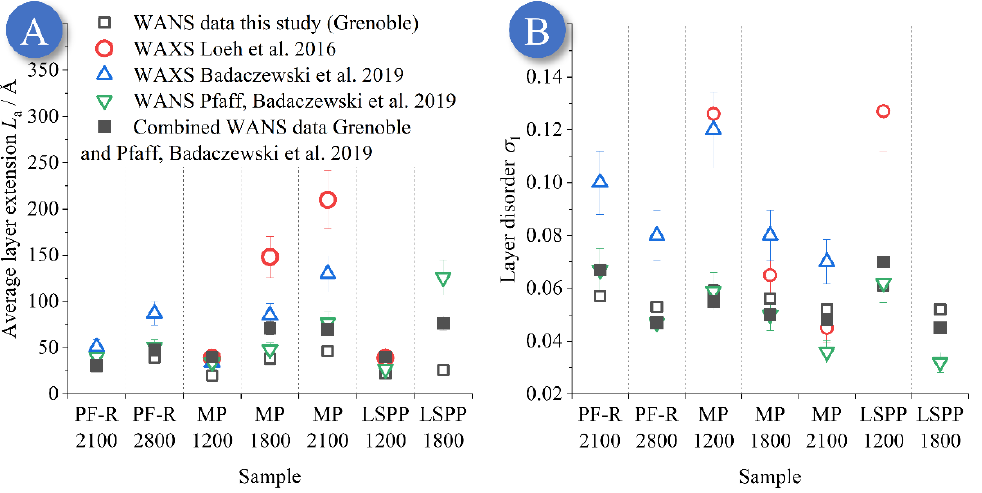
Figure 11. ( A , B ): Comparison of L a ( A ) and σ 1 ( B ) values obtained from different scattering experiments using X-ray and neutron radiation for identical samples. Black border only: WANS results from WANS data collected in Grenoble. Red: WAXS results from Loeh et al. (2016) [40]. Blue: WAXS results from Badaczewski et al. (2019) [37]. Green: WANS results of Pfaff et al. (2019) [43]. Black filled: results from the combination of WANS data from Grenoble and Pfaff et al. [43]. In general, WANS measurements lead to more accurate results for the layer structure because of the larger accessible s -range and the absence of the atomic form factor.